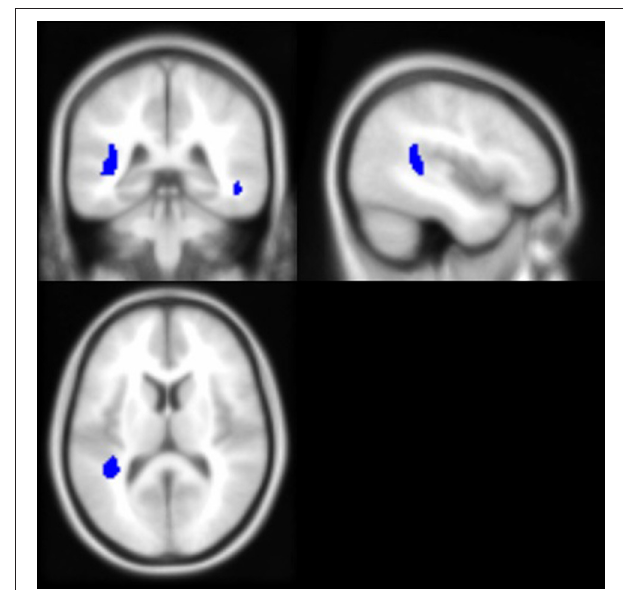
FIGURE 3 | Brain images depicting white matter regions in which APOE ε 4 carriers had smaller volumes compared to non-carriers, controlling for age and intracranial volume ( p < 0.001, k > 50). These regions (in blue) are within the right middle temporal and left superior temporal white matter; MNI coordinates for depicted image slices: − 44, − 38,